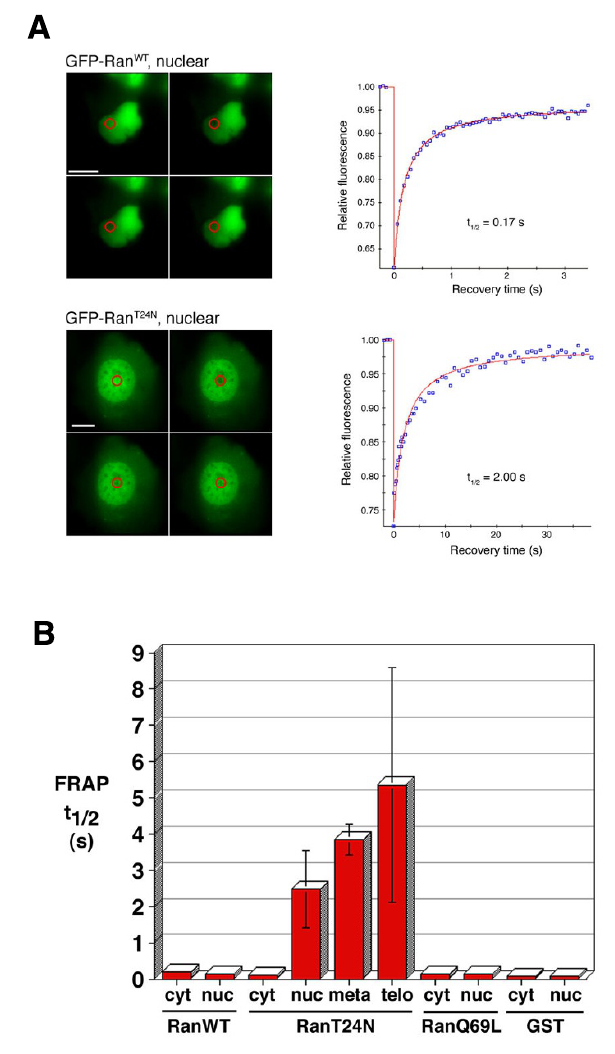
considerably, with the mean FRAP t metaphase, and 5.35 s in